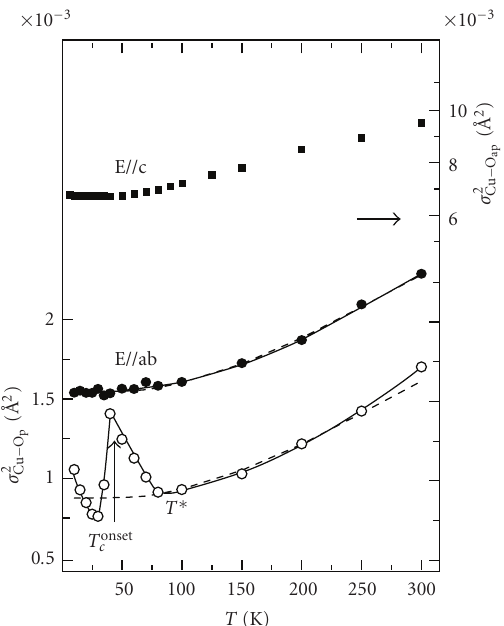
Figure 4: Mean-square relative displacement of the Cu-O bond in superconducting La 1 − x Sr x CuO 4 ( x = 0 . 15) with the in- plane ( E // ab ) and out-of-plane ( E // c ) geometries as a function of temperature. Closed and open circles denote the results for Cu-O p ( in-plane oxygen) measured for superconducting and non- superconducting samples (prepared by doping 3% Ni), respectively. Closed squares represent the mean-square oxygen displacement for the Cu-O ap ( out-of plane oxygen) in superconducting LSCO. Data were taken from Figure 3: Temperature dependence of the Fe–As bond mean-square relative displacements for LaFeAsO 0 . 93 F 0 . 07 (squares) and LaFeAsO (circles). The red and green symbols denote the results for the Fe K edge and the As K edge EXAFS data respectively, taken from [10]. The inset shows an enlarged view of low temperature ( T < 100 K) mean-square relative displacements (MSRD) for the LaFeAsO 0 . 93 F 0 . 07 sample plotted as the function of normalized ) compared to the result for La 1 . 85 Sr 0 . 15 CuO 4 . temperature ( T / T onset c